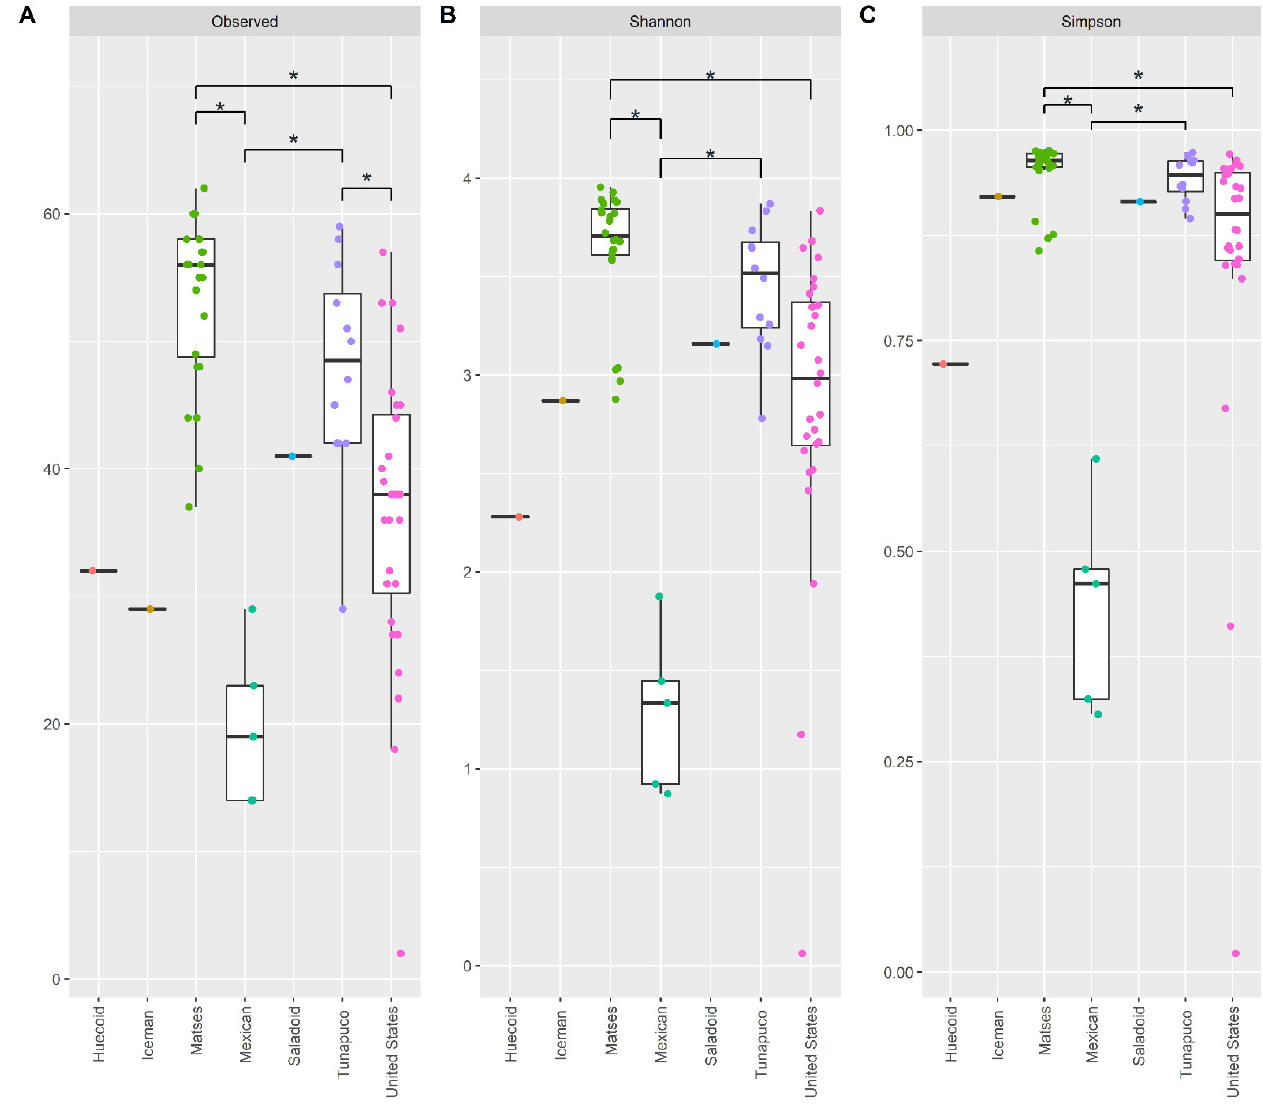
Figure 2. Alpha-diversity comparisons of the gut mycobiomes of each ethnic group. Analyses were performed at the genus-level. Boxplots show ( A ) observed richness, ( B ) Shannon, and ( C ) Simpson diversity of each ethnic group. Individual observations (dots) were colored according to ethnic group; * p <